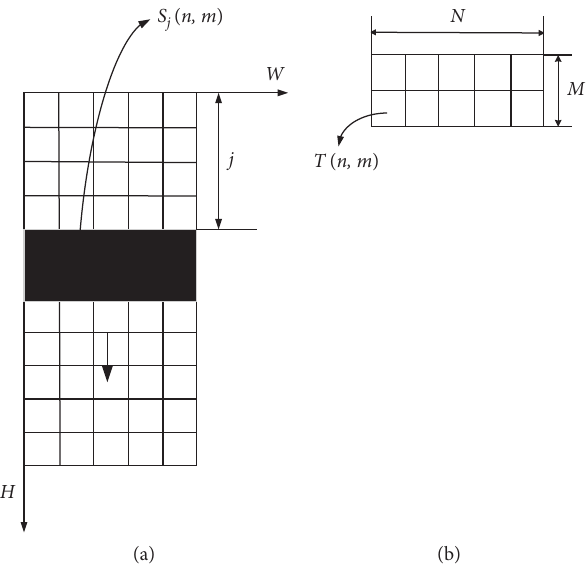
Figure 4: 3Schematic diagram of template matching in vertical direction. (a) Searched image S S ( W , H ). (b) Template image T T ( N , M